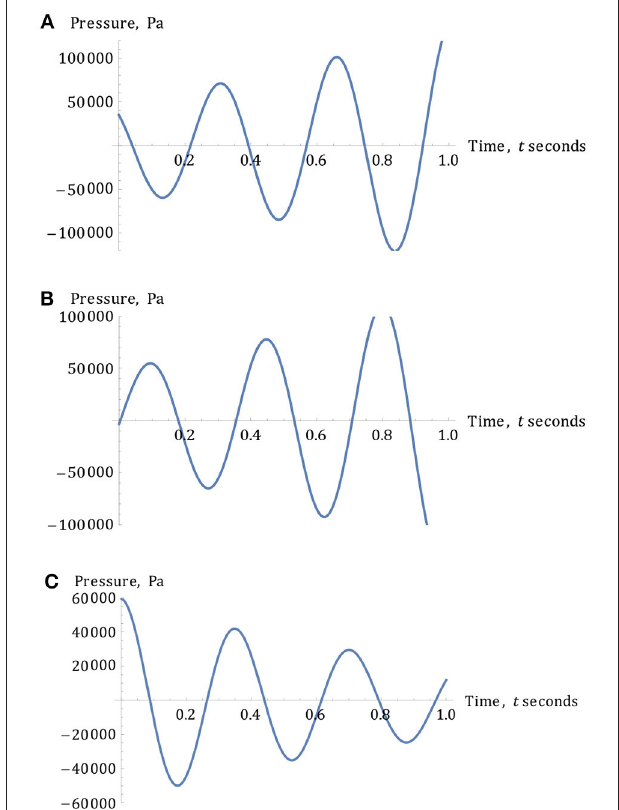
FIGURE 14 | (A) The variation of wave-pressure vs. time for any pressure magnitude and for any positive- or negative-valued shear wave-velocity, c . 1 c x − ( t − t 0 ) , as t , Therefore, the solution blows-up given e − → ∞ (cid:17) → ∞ (cid:16) where x c is both fixed and finite, and is eventually exceeded by the increasing temporal-variable, t . In this diagram, a wave-velocity of c 4 m/s was = adopted to highlight the phase-shift more clearly. Note the apparent existence of an under-pressure between the occurrence of the phase and the time t 0.2s. (B) The variation of wave-pressure vs. time for any pressure = magnitude and for any positive- or negative-valued larger shear wave-velocity , as of c was adopted. Therefore, the solution blows-up given e − 1 c ( x − ct ) ) → ∞ t , where x c is both fixed and finite, eventually exceeded by this → ∞ increasing temporal-variable, t . In the plotting of this diagram, the wave-velocity of c 40 m/s was used. (C) A solution curve for the variable = 1 sin c x − ( t − t 0 ) α e pressure: u ( t , x ) = (cid:16) (cid:17) 125 0.176m, t 0 4.65 10 − 4 s, x 0 2.325 10 − 3 m, c 4m/s, ω 22 π , = × = × = = and α 54,500 Pa, each scaled appropriately to yield a maximum test = pressure at t 0 4.65 10 − 4 s of 50,000Pa. Graphs for any values of the = × shear wave-velocity c are similar, as before, although for higher values than 4 m/s the phase approaches the origin more closely and rapidly. Note the initial under-pressure in this